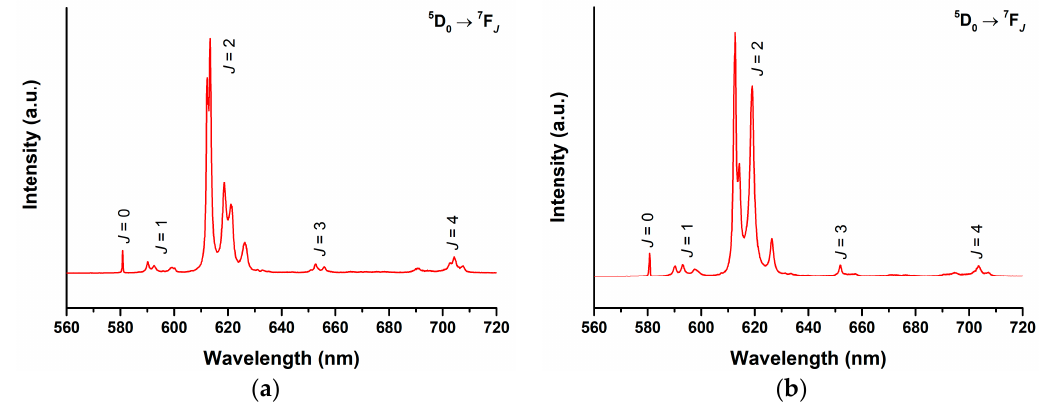
Figure 6. Solid-state photoluminescence spectra of ( a ) [Eu( pp -dbm-Cl 2 ) 3 phen] and ( b ) [Eu( mm -dbm- Cl 2 ) 3 phen]. Measurement condition: λ ex = 360 nm, slit = 0.5–0.1, and longpass filter = 380 nm.